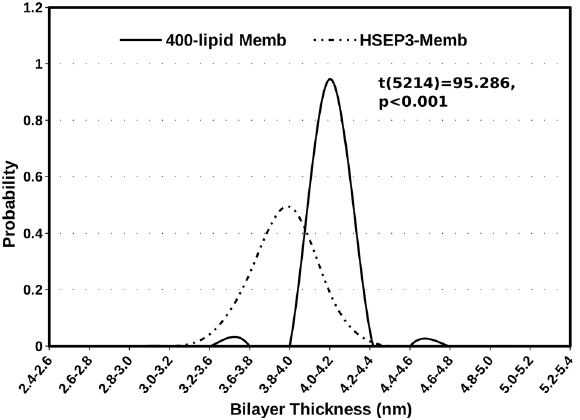
Fig. 7 Distribution of bilayer thickness values ( D P-P ) for trajectory snapshots for membrane and HSEP3-bound membrane simula- tions. A two-sample t -test assuming unequal variances shows that the mean membrane thickness values are signi fi cantly different (two-sample t(df = 5213) = 95.286, p <